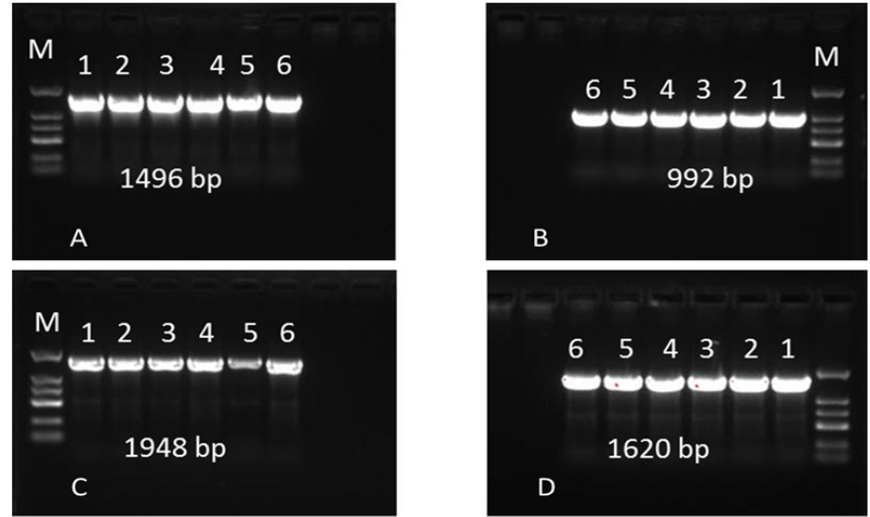
Figure 7. PCR amplification results of Bos1 gene fragments of B. cinerea sensitive and resistant strains. Note: M: DNA Maker; 1–6 were 5055, 5055-R1, 5055-R2, 5055-R3, 5055-R4, and 5055-R5, respectively. ( A – D ) indicate that Primer 1–4 amplified